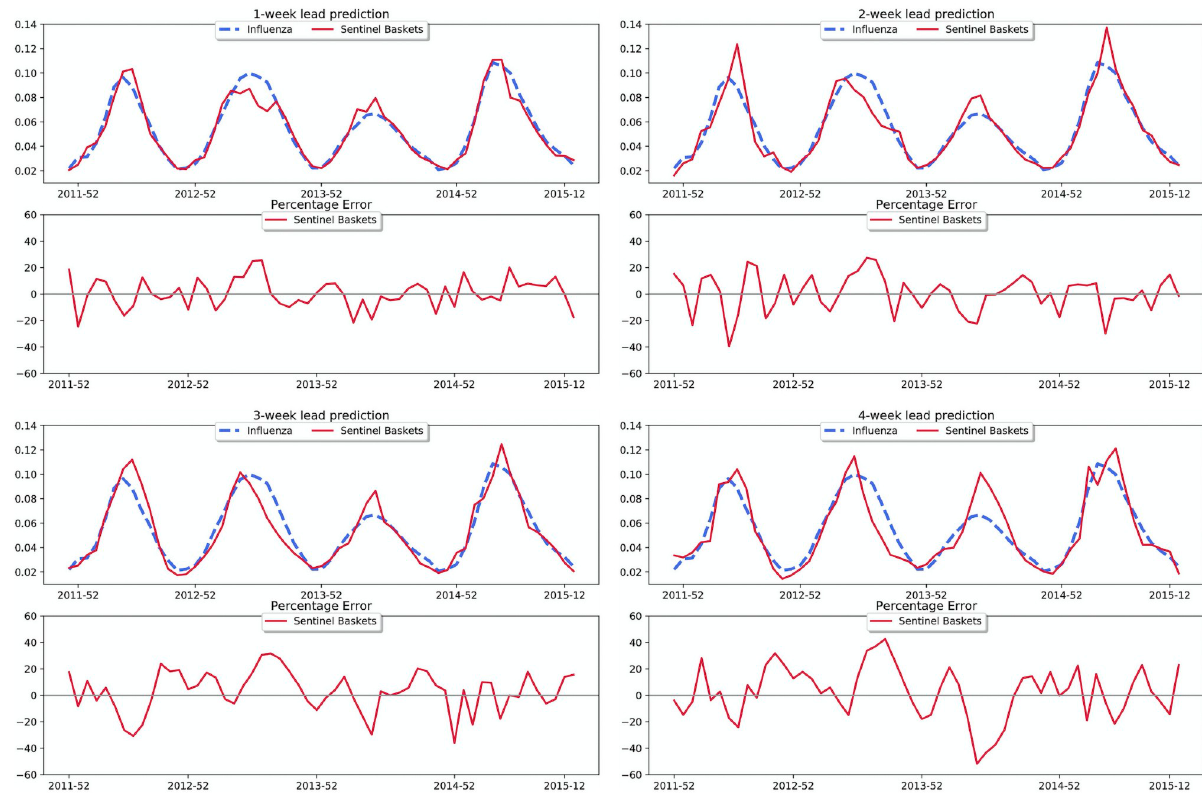
Fig 1. Predictions for 1–4 weeks ahead. The top plot of each panel shows the ground truth influenza activity time series along with the predictions from our framework using the sentinel baskets . The time dependent percentage error is displayed in the bottom plot of each panel.